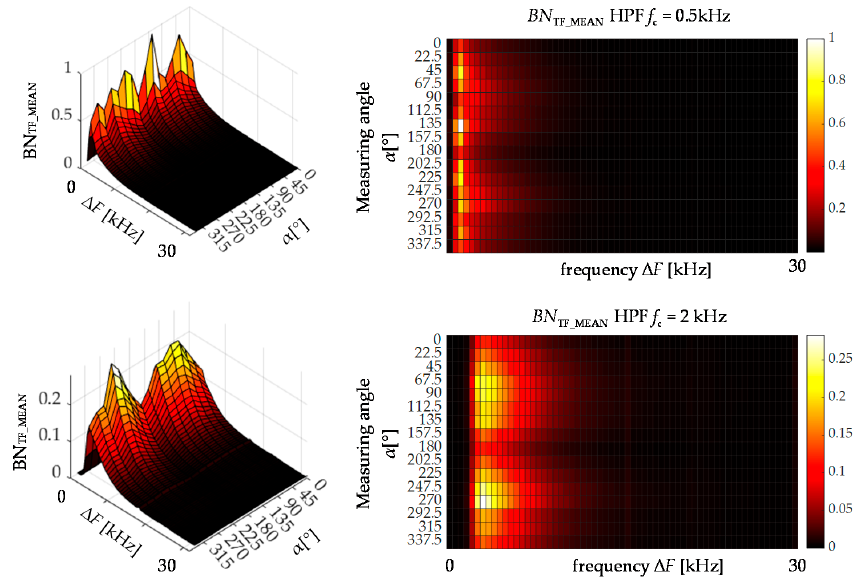
Figure 9. Visualization of the BN TF_MEAN angular distribution in successive frequency ranges of the spectrogram; left column is a perspective presentation of the results in the right column.